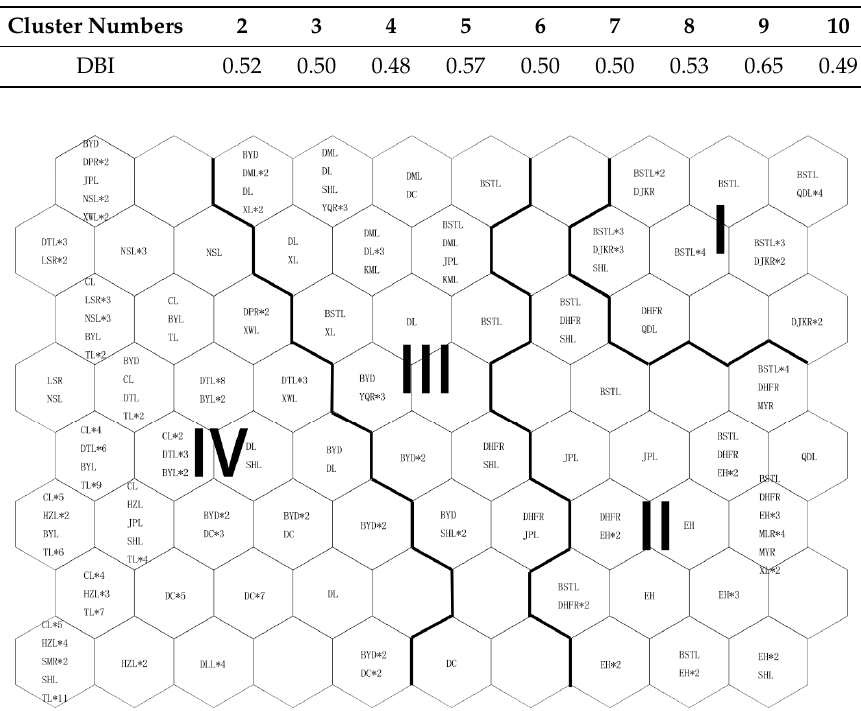
Table 1. Davies-Bouldin index (DBI) values of different numbers of clusters on the trained SOM.